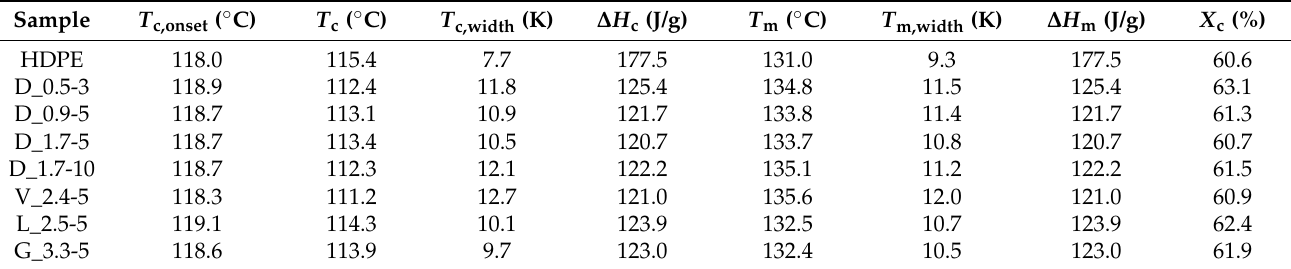
Figure 4. DSC thermograms of samples: ( a ) first cooling run; ( b ) second heating run. Table 5. Thermal properties of samples determined by DSC.